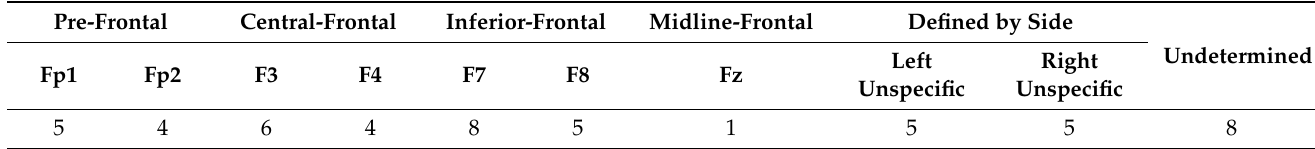
Table 1. Distribution of seizure onset location.